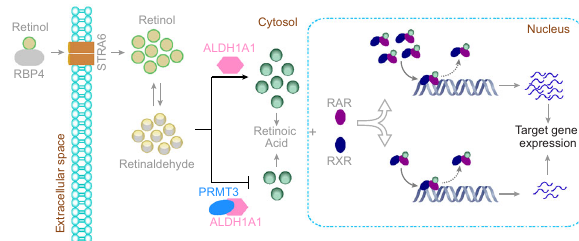
Fig. 8 Schema illustrating the functional signi fi cance of PRMT3 – ALDH1A1 interaction. PRMT3 interacts with ALDH1A1 and inhibits the enzymatic activity of ALDH1A1. This interaction negatively regulates retinoic acid signaling-mediated gene